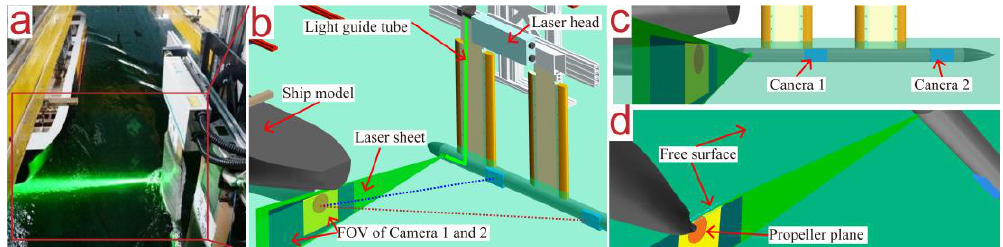
Figure 2. Experimental setup of SPIV measurement: ( a ) photograph of SPIV setup in the towing tank; ( b ) schematic diagram of SPIV setup; ( c ) close-up of the position of the propeller plane and PIV system; ( d ) close-up of the position of the propeller plane, free surface, and laser sheet.